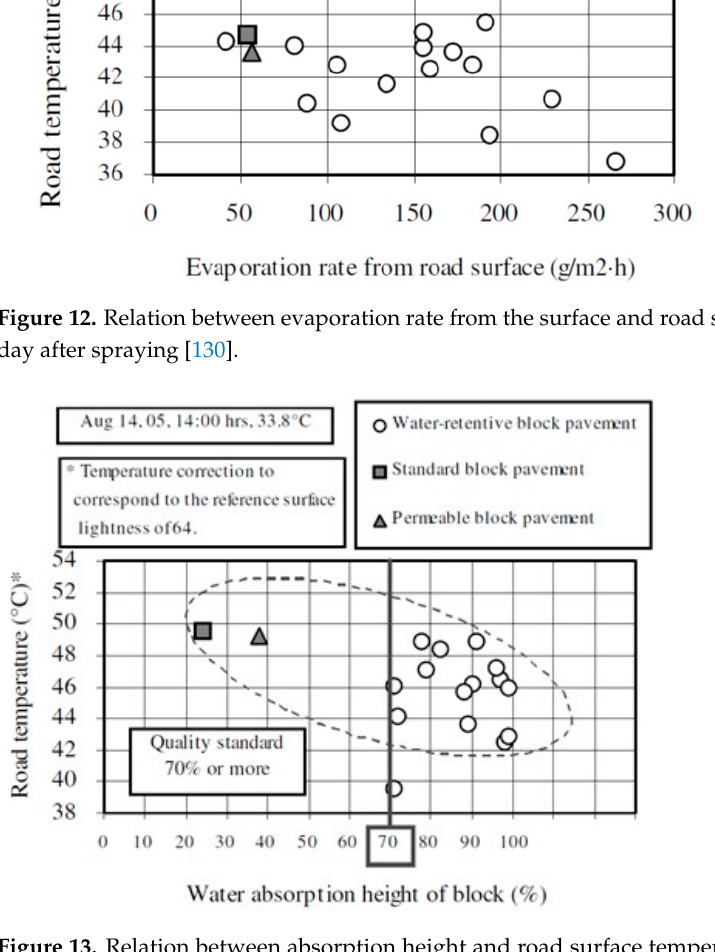
Figure 13. Relation between absorption height and road surface temperature on the day after the rain [130].